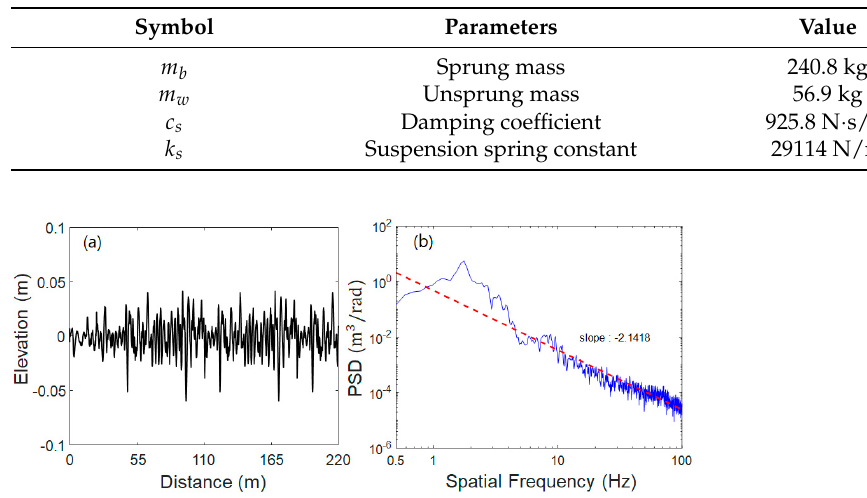
Table 2. Parameters for the simulation of the quarter-car suspension model and AEKF-UI.